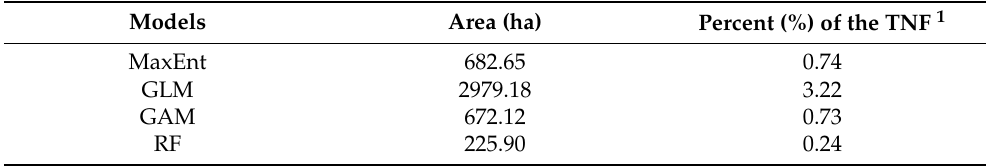
Suitable areas based on the models for the turkeybeard species in the